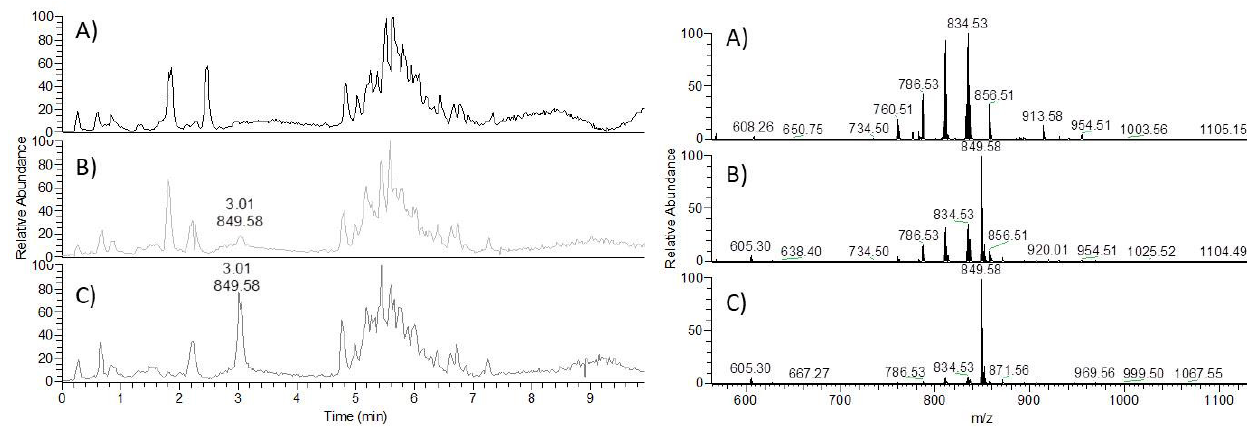
Figure 5. Chromatograms and mass spectrum acquired at 3 min. of pure matrix extract ( A ), matrix spiked with 300 ng ( B ) and 1500 ng ( C ) of Sulfavant A. Chromatograms were obtained as m / z mass range between 400 and 1200. Table 3. Accuracy and precision of quality control (QC) samples of Sulfavant A during intra-day and inter-day analysis. SULF A in MeOH